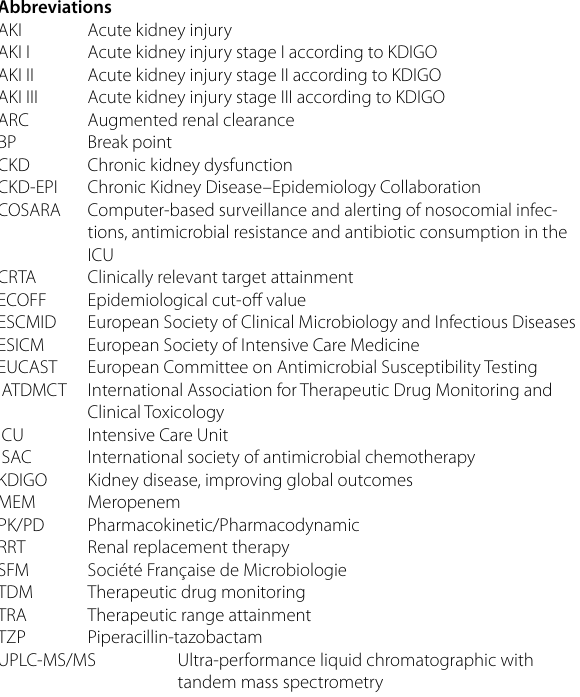
to the BP and renal function. Figure S6 . Percentage of non-steady state TZP samples within the therapeutic range for different BP multiplications according to the BP and renal function. Figure S7 . Percentage of CRTA for all MEM samples according to renal function and BP multiplication. Figure S8 . Percentage of CRTA for MEM steady state samples according to renal function and BP multiplication. Figure S9 . Percentage of CRTA for MEM non-steady state samples according to renal function and BP multiplica- tion. Figure S10 . Percentage of all MEM samples within the therapeutic range for different BP multiplications according to the BP and renal function. Figure S11 . Percentage of steady state MEM samples within